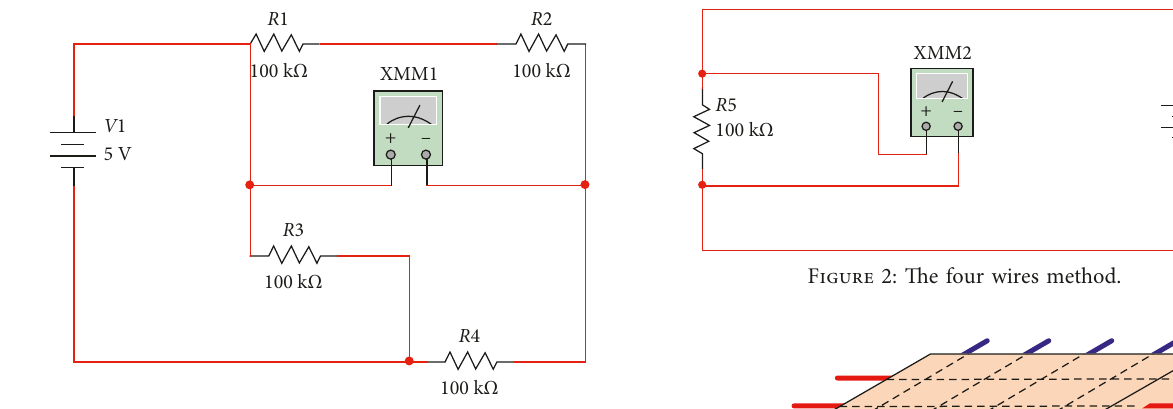
Figure 1: The three wires method.